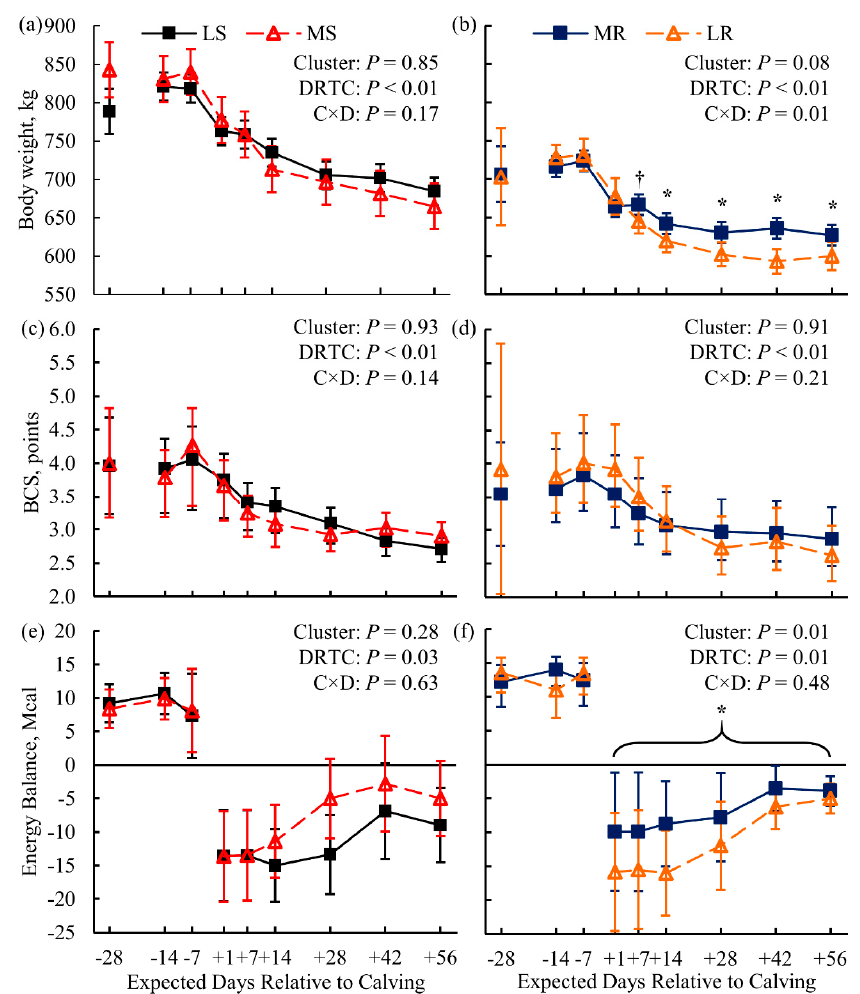
Figure 1. Body weight (panels a and b ), body condition score (BCS; panels c and d ), and calculated energy balance (panels e and f ) for dairy cows clustered based on postpartum lipid metabolites within the original dietary treatment. Left-hand panels compare cows less (LS) or (MS) susceptible to lipid-related metabolic disorders, while right-hand panels compare cows more (MR) or less (LR) resistant to lipid-related metabolic disorders ( n = 3 cows per cluster). Data are presented as least squares means (points) and their 95% confidence intervals (error bars); the exceptions are the arithmetic mean and 95% confidence interval for the − 28 DRTC timepoint covariates (panels a – d ). Statistics for the fixed effects of cluster, day relative to calving (DRTC), and their interaction (C × D) across the experimental period (panels a – d ) or the postpartum period (panels e and f ) are displayed in the top-right corner of each panel. Significant (*, p ≤ 0.05; Bonferroni adjusted) or marginal evidence (†, p = 0.07; Bonferroni adjusted) for the effects of cluster within DRTC or contrast of cluster across postpartum samples (bracketed) are indicated within their respective panels.